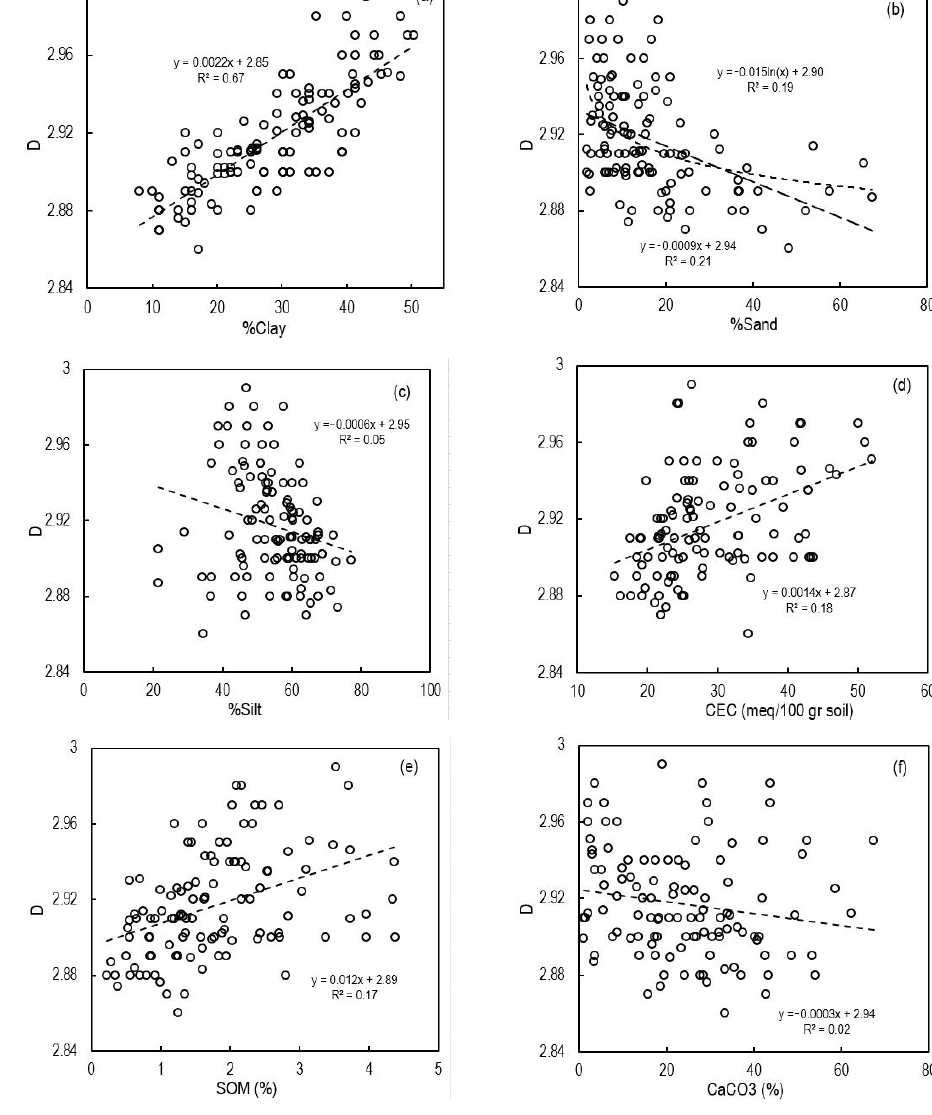
Figure 5. Relationship between D and ( a ) %clay, ( b ) %sand, ( c ) %silt, ( d ) CEC, ( e ) SOM, and ( f ) CaCO 3 ( n = 113). However, our findings differ from those of Deng et al. [8] and Peng et al. [7], who found a positive correlation between D and %silt. A positive non-linear relationship was also observed between SOM and D (R 2 = 0.17), whereas CaCO 3 did not show a clear